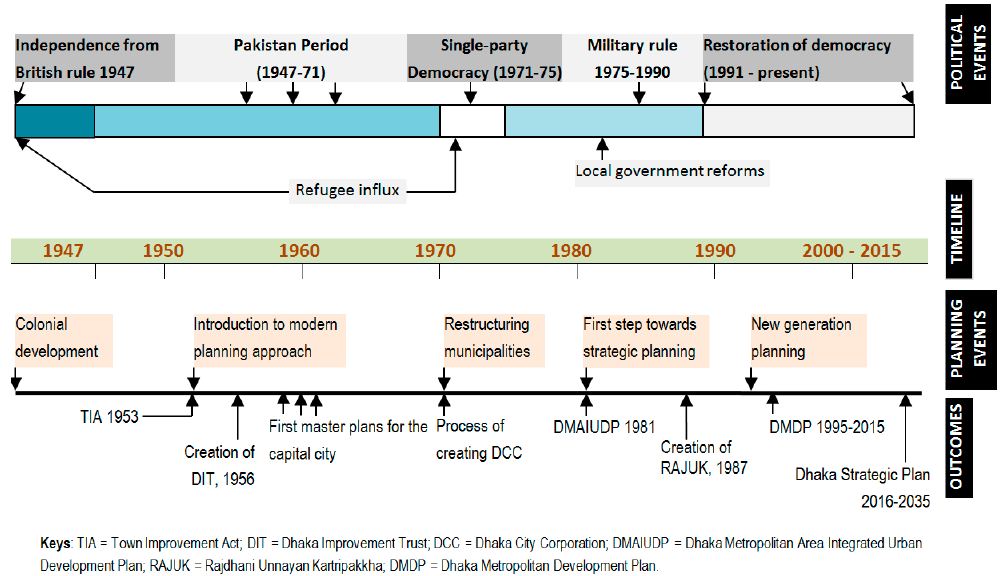
Figure 3. Temporal map of the evolution of urban planning and development process in Megacity Dhaka (adopted from [47]).